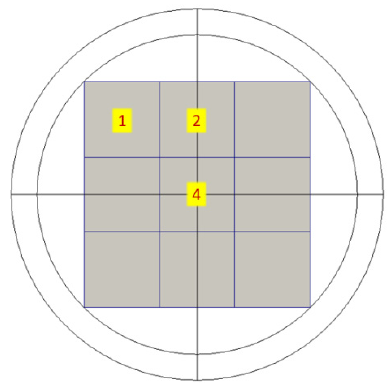
Figure 11. The quantitative distribution of the additional PIPEs at the core inlet/outlet planes. TRACE first runs a Steady-State (SS) simulation. During the SS, the inlet velocity at loop1 is 15 m/s. Inlet velocities of the other three loops are identical to 10 m/s. The inlet coolant temperature is 400 K. The outlet pressure is 15.55 MPa. After the SS, a TRACE transient (TS) simulation is carried out. The total problem time is 50.0 s. The boundary conditions for the transient are given in Table 1. Table 1. The boundary conditions during the